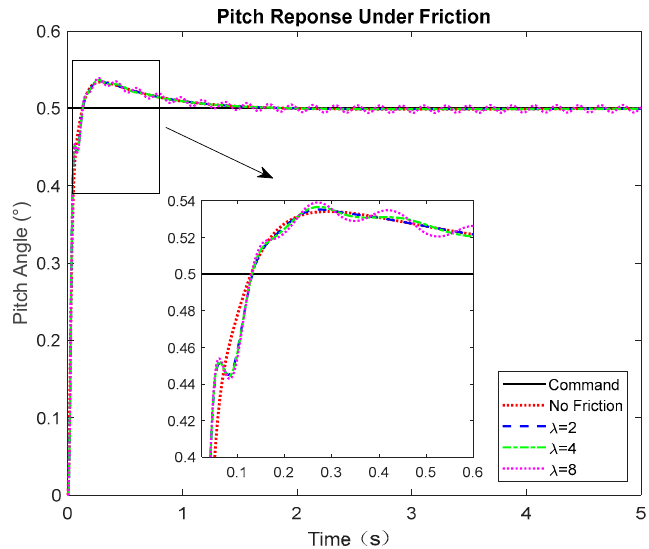
Figure 7. Pitch response under friction.